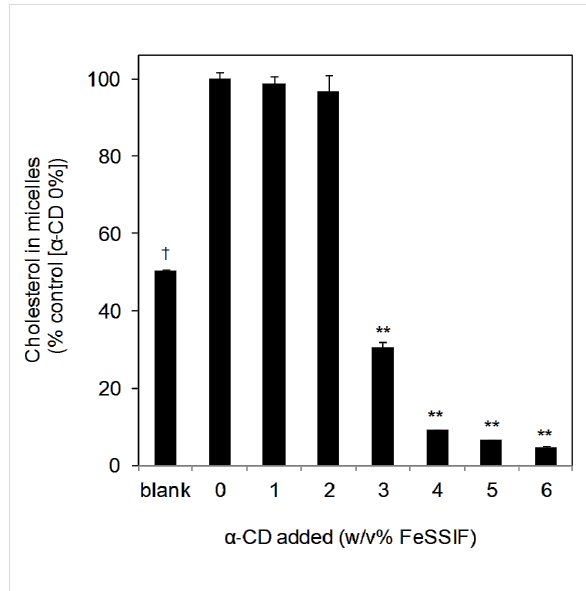
Figure 6: Dose-dependent decrease of the micellar cholesterol solu- bility in the FeSSIF by α -CD. After addition of each amount of α -CD into 15 mL of the FeSSIF or an alternative buffer (37 °C) and mixing for a few seconds, the mixture was shaken at 37 °C for 30 minutes at 100 rpm. Thirty milligrams of cholesterol was then added into the mix- ture, and the mixture was shaken for 120 minutes at 37 °C at 100 rpm. After centrifuging the mixture for 10 minutes at 10,000 rpm, the super- natant was filtered using a 0.2 μ m PTFE filter. The blank value gives the amount of cholesterol originally dissolved in the FeSSIF. Means and standard errors are indicated ( n = 3). ** ,† P < 0.01, significantly different from control ( α -CD